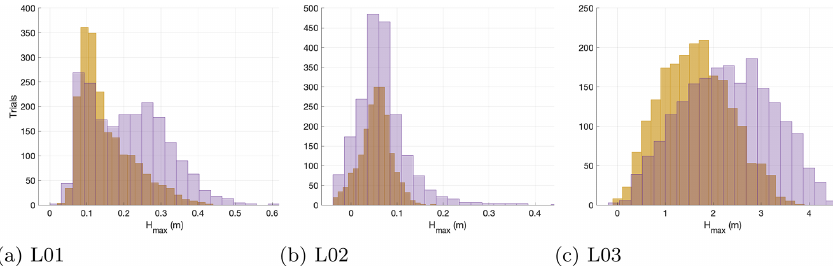
Figure 11. Predictions for three cell centres of the grid (see locations 01, 02 and 03, respectively, in Fig. 4) for scenarios resulting from the distributions H1 (buried ruptures; prediction histograms in yellow) and H2 (splay-faulting; prediction histograms in purple).